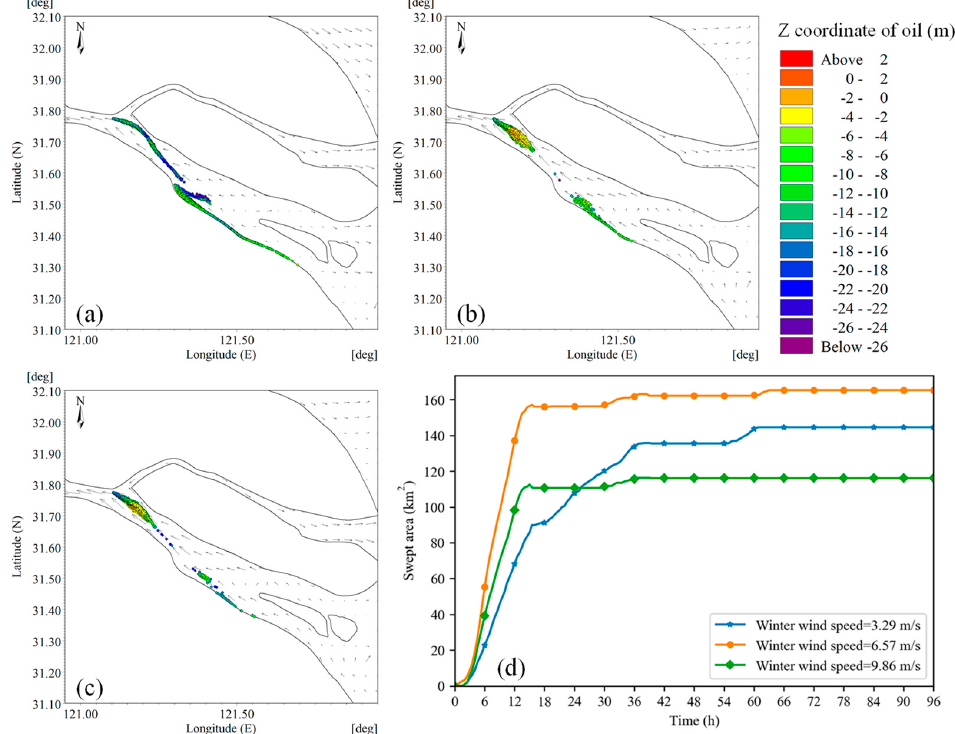
Figure 15. ( a – c ) oil particle trajectories under the influence of wind speeds of 3.29 m/s, 6.57 m/s, and 9.86 m/s, respectively; ( d ) swept area (km 2 ) change with three different wind speeds. The color of circles indicates the z coordinate of oil particles.